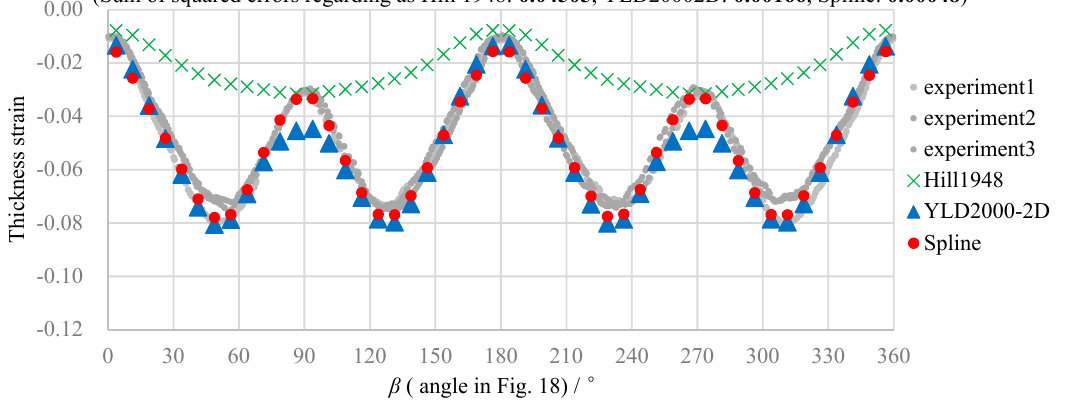
Figure 23. Comparison of thickness strain distributions on circle 2 in experimental condition B.